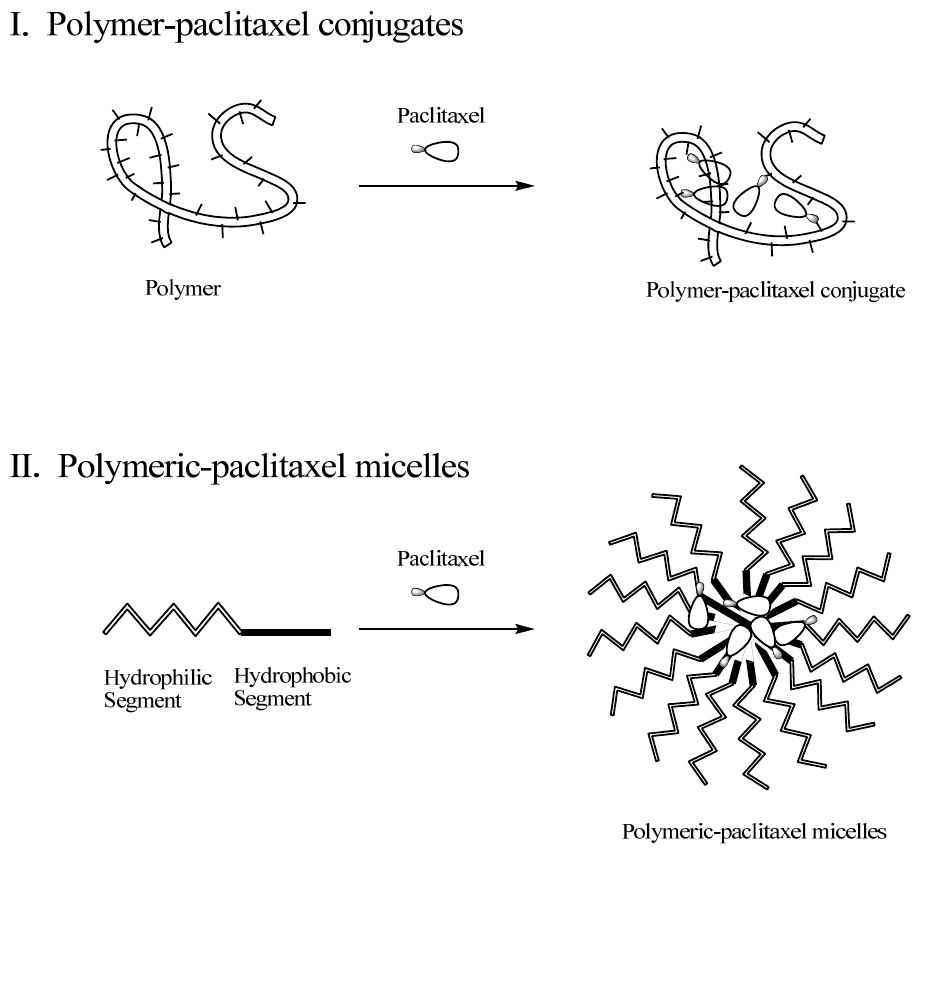
Figure 1. Schematic representation of polymer-paclitaxel conjugates ( I ) and polymeric- paclitaxel micelles ( II